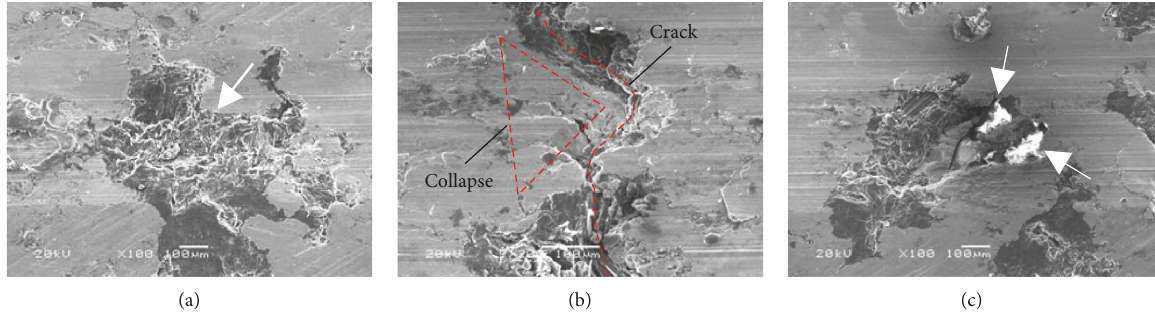
Figure 8: Surface defects of the grooves. (a) Irregular pit. (b) Collapse and crack. (c) Broken particle.